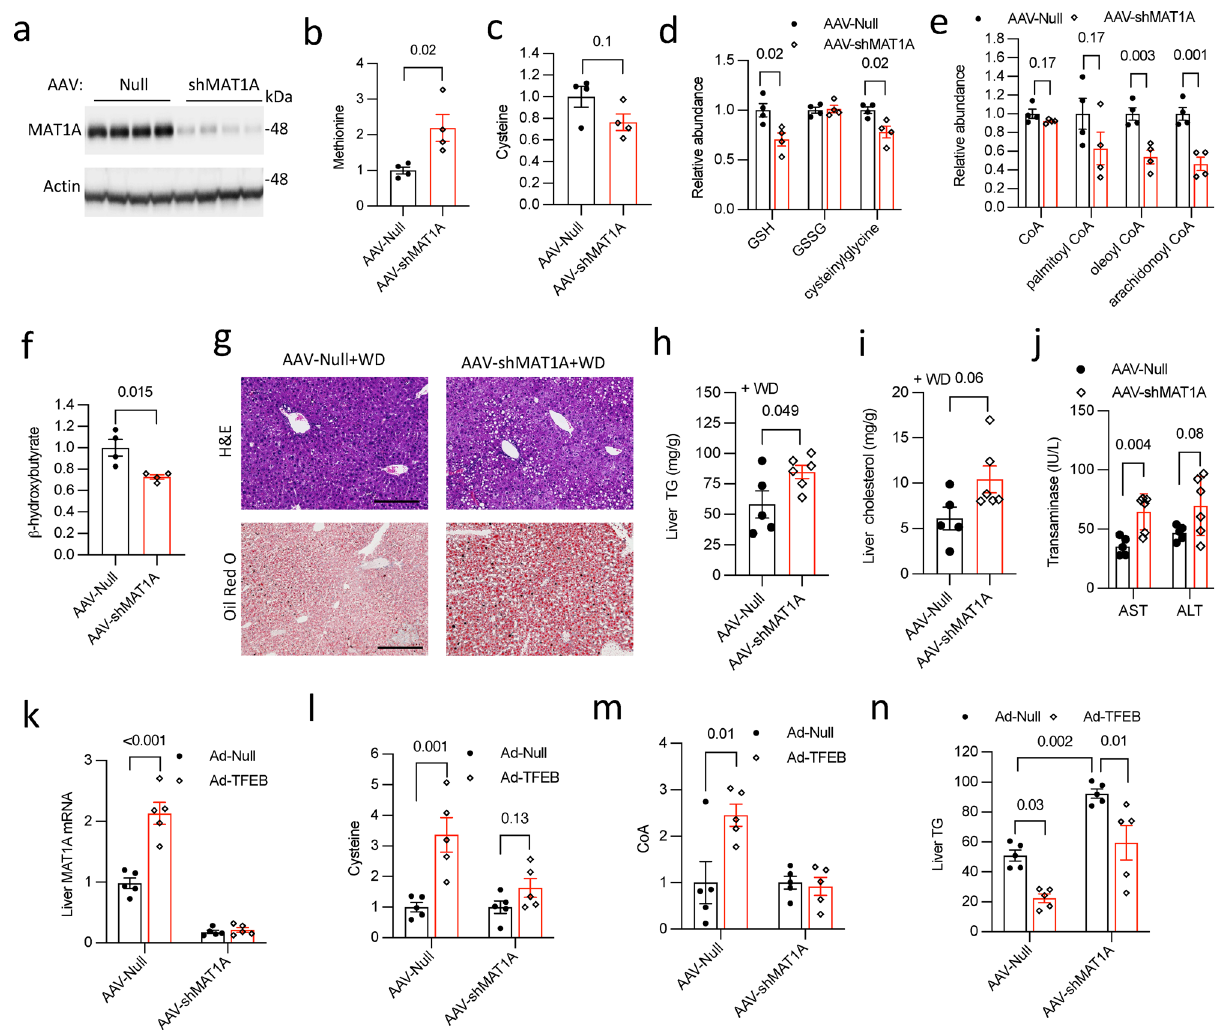
Fig. 5 | Hepatic MAT1A de fi cient mice have reduced hepatic cysteine and CoA pool and higher susceptibility to developing steatosis and liver injury when challenged with Western diet. a – f Male 10 weeks old C57BL/6J mice were intra- venously injected with AAV-Null or AAV-shMAT1A at 2X10 11 GC/mouse. Mice were maintained on chow diet for 2 weeks and euthanized after 6h fast ( n =4). a Liver methionine adenosyltransferase 1A (MAT1A) protein. Each band represents an individual mouse sample. b , c , d , e , f Relative abundance of liver metabolites is shownwithcontrolarbitrarilysetas1.GSH:reducedglutathione;CoA:coenzymeA. g , h , i , j Male10weeksoldC57BL/6JmicewereintravenouslyinjectedwithAAV-Null or AAV-shMAT1A at 2X10 11 GC/mouse. Mice were then fed Western diet (WD) for